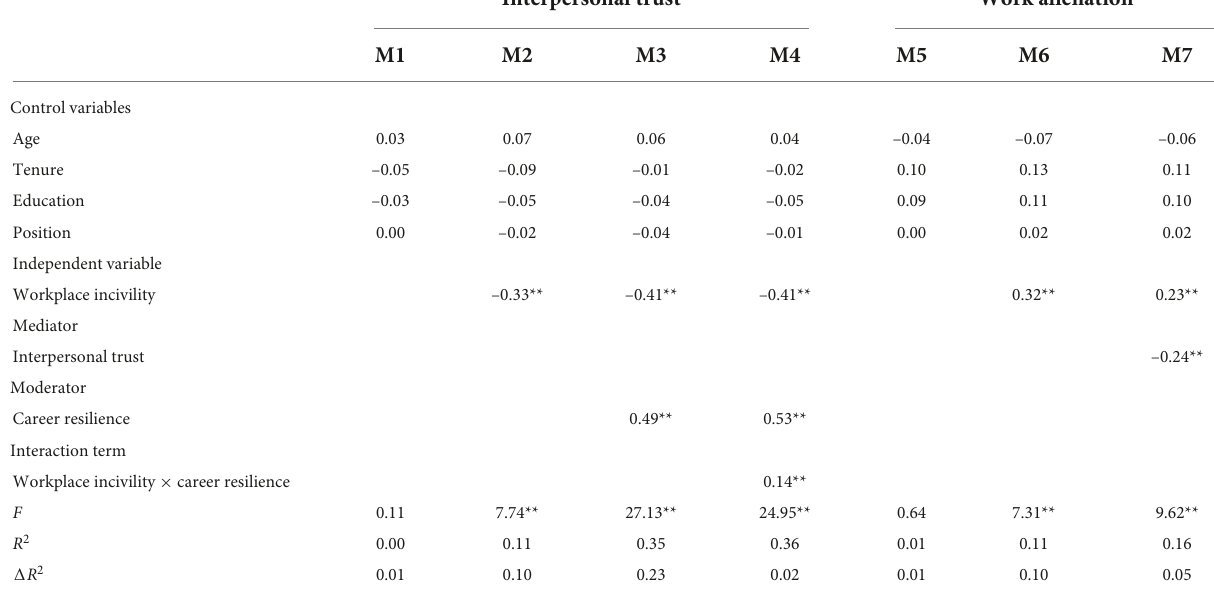
TABLE 3 Regression